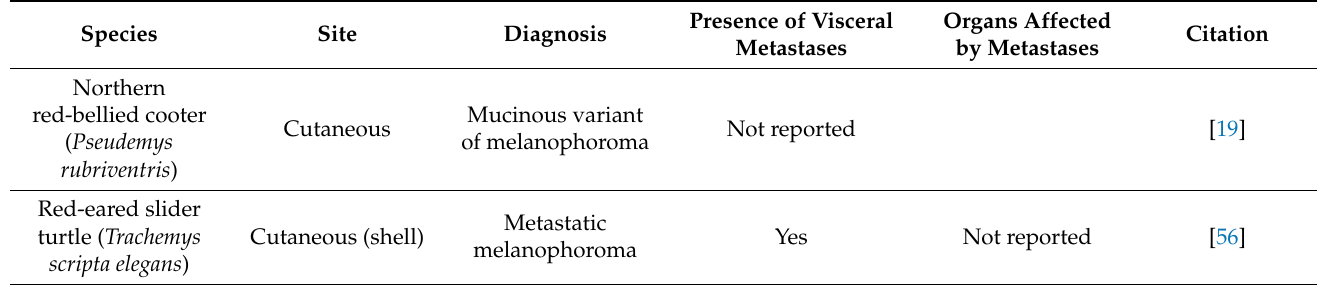
Table 13. Clinical features of chromatophoromas in the reptile family: Emydidae